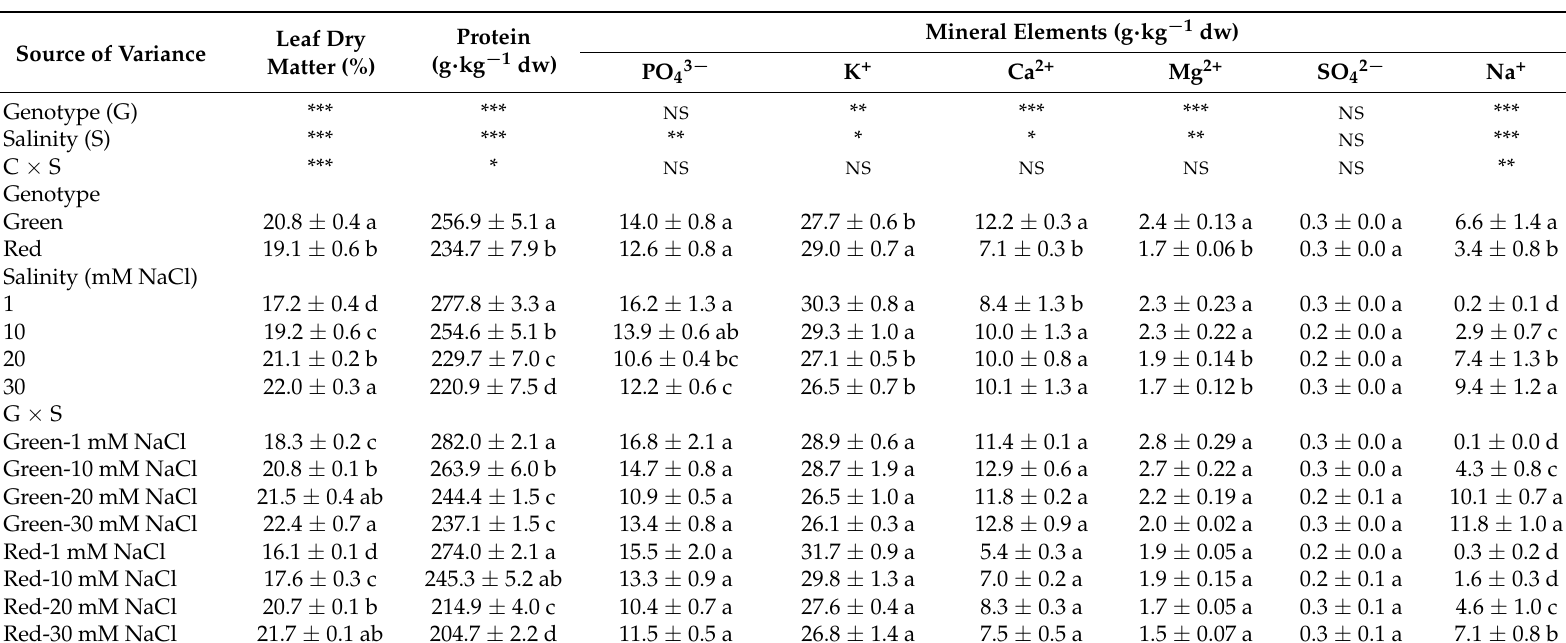
Table 2. Analysis of variance and mean comparisons for mineral composition of leaves in green and red perilla grown under increasing NaCl concentration in the nutrient